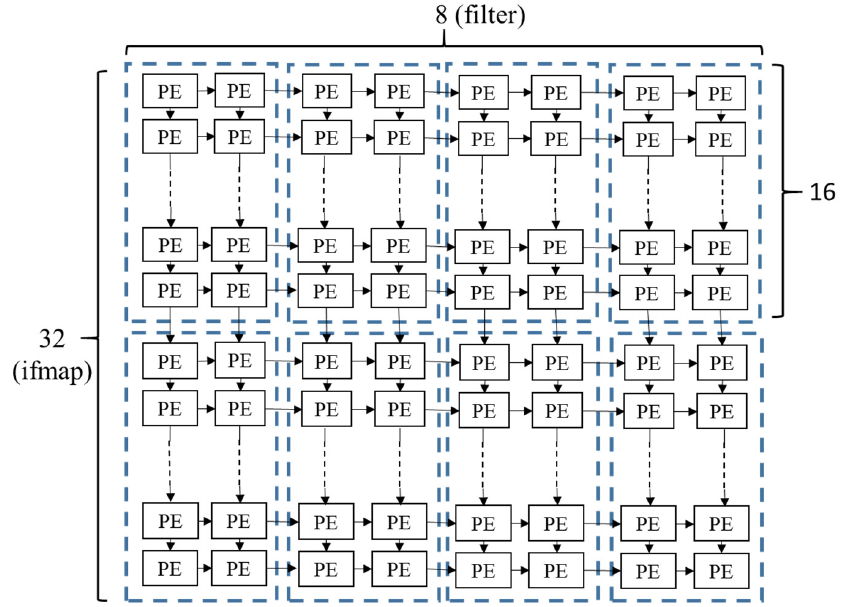
Figure 6. Cluster-based PE array configuration.